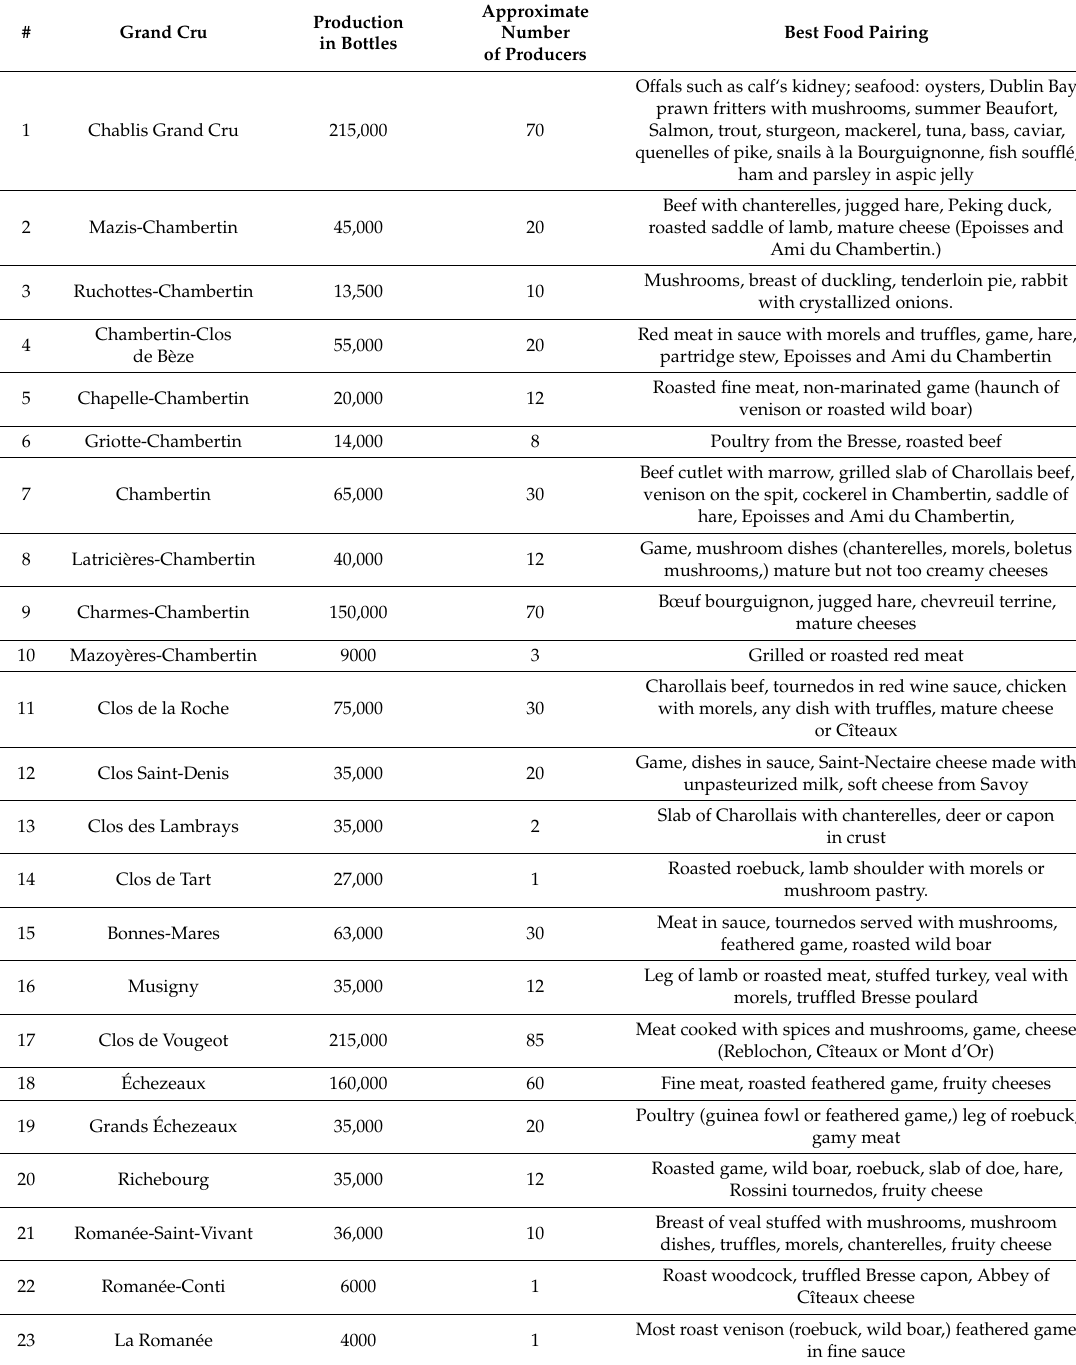
Table 4. Inventory of food pairing with Burgundy Grands